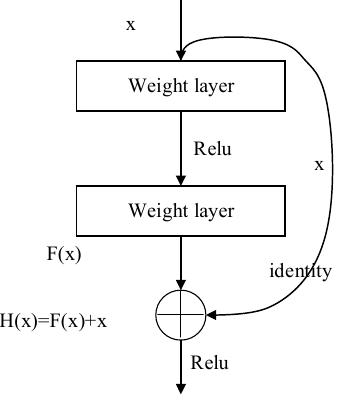
Figure 4. Residual network structure.